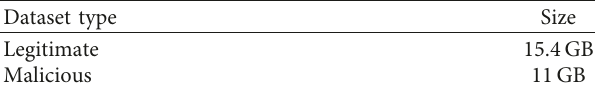
Table 1: Description of experiment dataset.